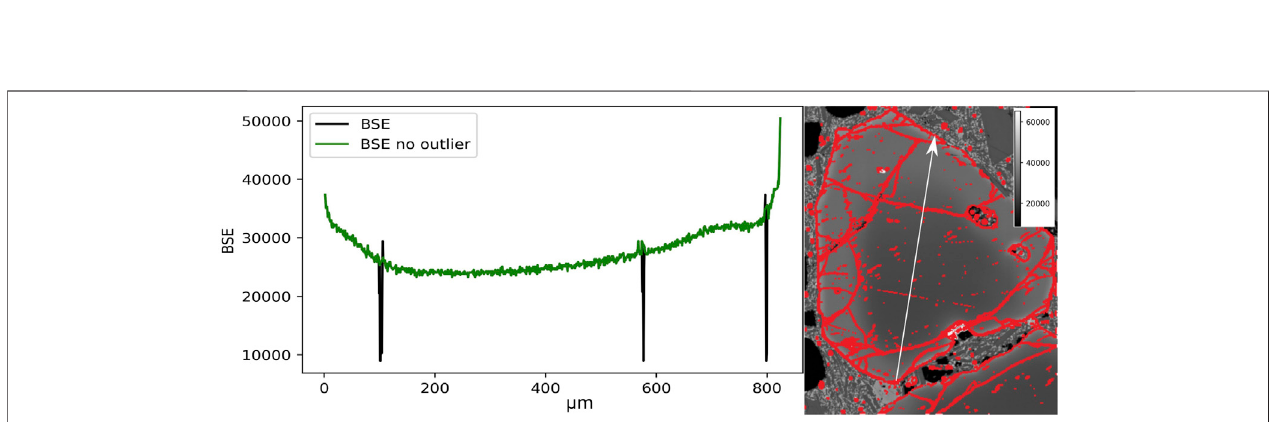
FIGURE6| TheBSEimageofzonedolivinecrystal(VIcf. Figure1 )withtheoutliersmarkedinredandtheBSEgreyscaleintensitypro fi leillustratingthepresenceof signal outliers (cracks, impurities, holes, surface distractions). The green pro fi le shows fi ltered data obtained along the white arrow.